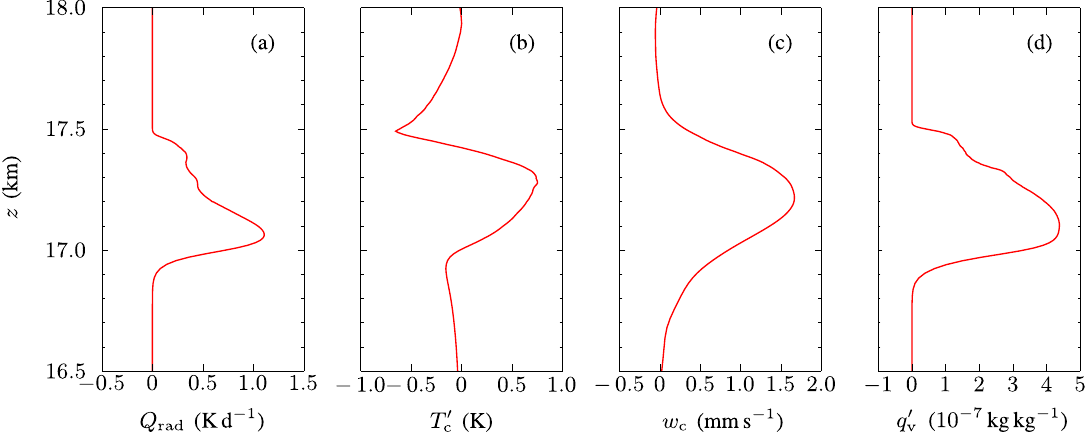
Fig. 9. Horizontal averages between x = 3200km and 3600km of the radiative heating rate (a) , its induced temperature perturbations (b) , its induced vertical velocity (c) , and perturbation water vapor mixing ratio (d) at 3 . 5d.